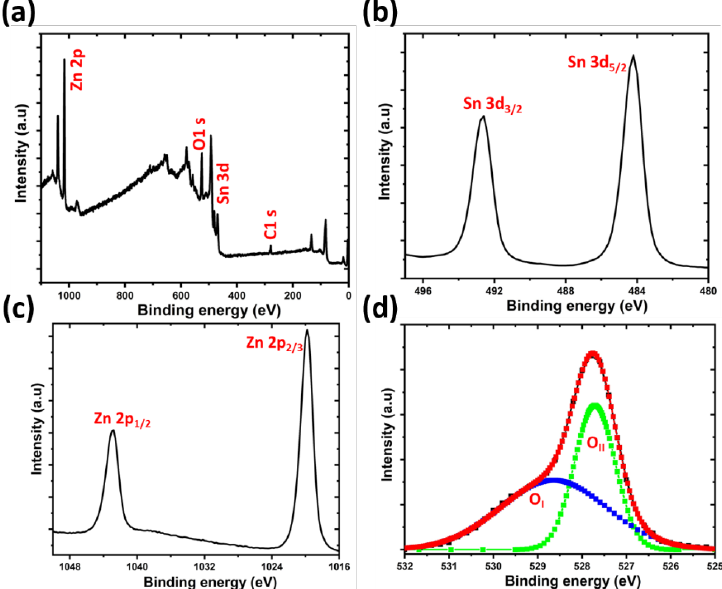
Figure 4. XPS spectrum and the fitted data; ( a ) full survey scan XPS spectrum of SnO 2 /ZnO heterostructures, ( b ) Sn 3d, ( c ) Zn 2p, ( d ) O 1s of SnO 2 /ZnO heterostructures.